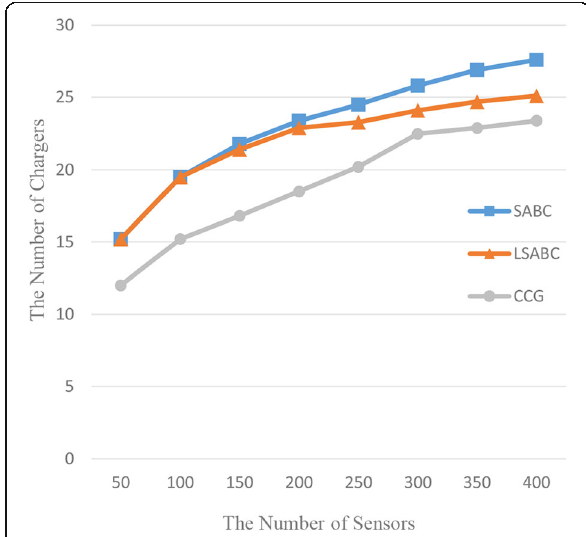
Fig. 9 Comparison between CCG, SABC, and LSABC